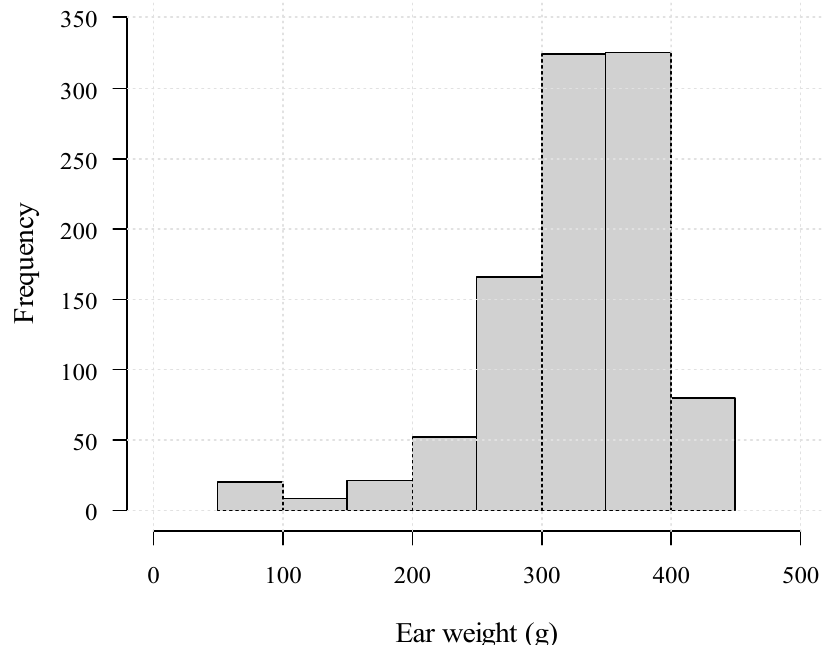
2.215 𝑥 : mean, SD: standard deviation, CV: coefficient of variance, var/𝑥 : relative variance In crop production modelling, using the plant-to-plant distance is expected to give more accurate results, although counting the number of crops per unit area is less time- consuming. The distribution of crop population can be derived from that of the plant-to- plant distance. In this study, the distribution of the plant-to-plant distance was found lognormal, while that of the plant population binomial. They are not interrelated, the distribution of the plant-to-plant distance is not necessarily lognormal, while the plant population is always expected binomial. Figure 5 shows the distribution curve for the individual ear weight, with the minimum of 50 g, maximum of 450 g, and mean of 330 g representing a hybrid with high